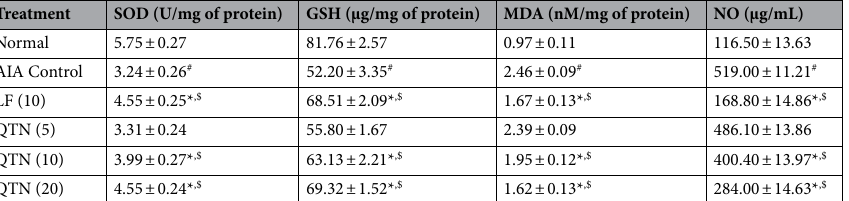
Table 4. Effects of QTN on FCA-induced alterations in antioxidant parameters in synovial tissues. Values in parentheses indicate a dose in mg/kg (n = 5–6). Data were analyzed by one-way ANOVA followed by Tukey’s multiple comparisons test. For comparison with AIA-control group: * p < 0.05, comparison with normal group: # p < 0.05 and comparison with one another: $ p < 0.05. AIA adjuvant-induced arthritis, LF leflunomide, QTN 3,5,7,3 ′ ,4 ′ -pentahydroxy flavone, SOD superoxide dismutase, GSH glutathione peroxidase, MDA malondialdehyde, NO Nitric